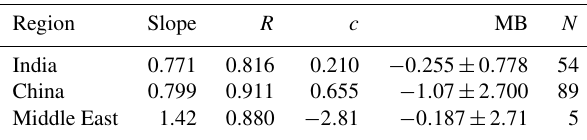
Table 1. The slope, correlation coefficient ( R ), intercept ( c ), mean bias (MB), and the number of points ( N ) of simulated (GEOS- Chem) and observed sulfate rainwater concentration over the three domains. Region